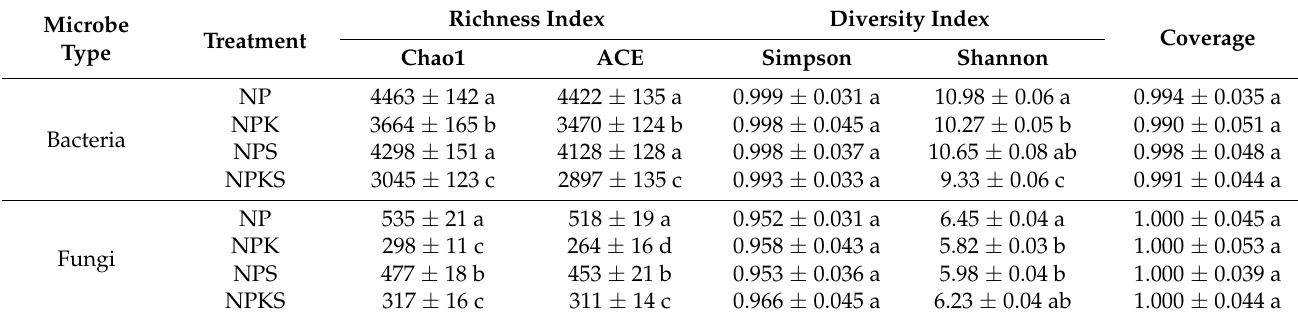
Table 3. Alpha diversity of bacterial and fungal gene sequences in the soil